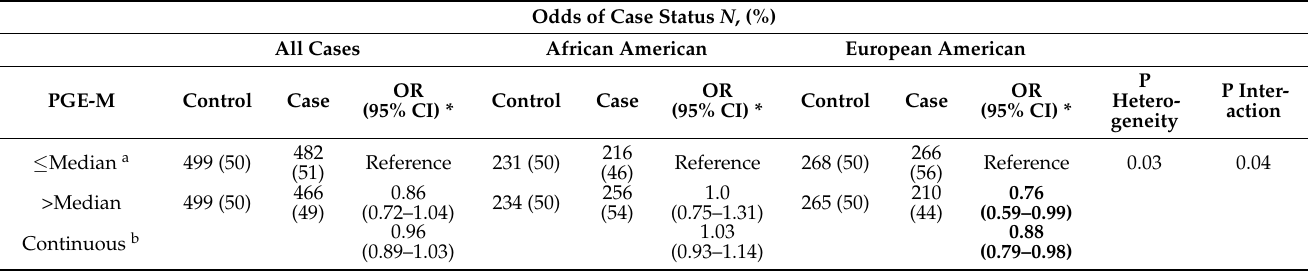
Table 1. Association of urinary PGE-M levels with prostate cancer.